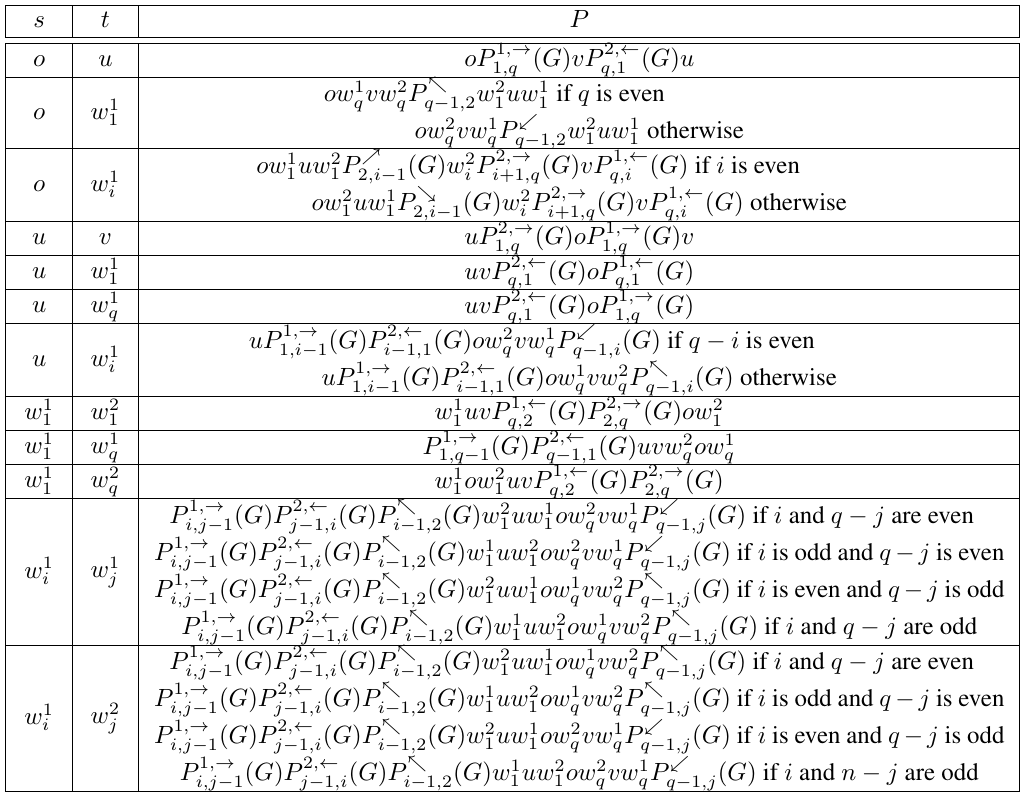
Tab. 2: Proof that Pr n is Hamiltonian-connected for every odd n ≥ 5